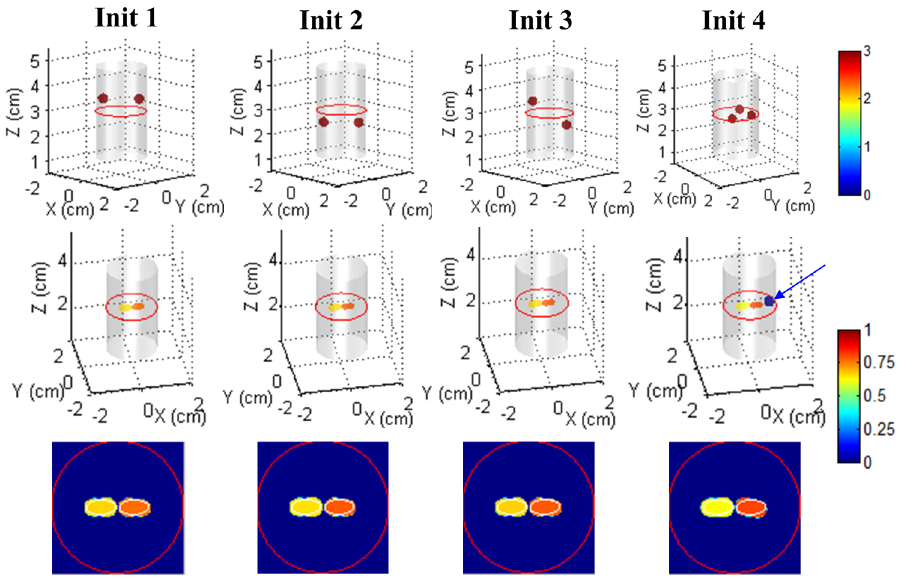
Figure 5. Reconstruction results with different initial estimates. In the slice images, the red circle denotes the boundary of the imaged object, and the white lines denote the boundaries of the real inclusions. The slice images are of 3.0 cm height.